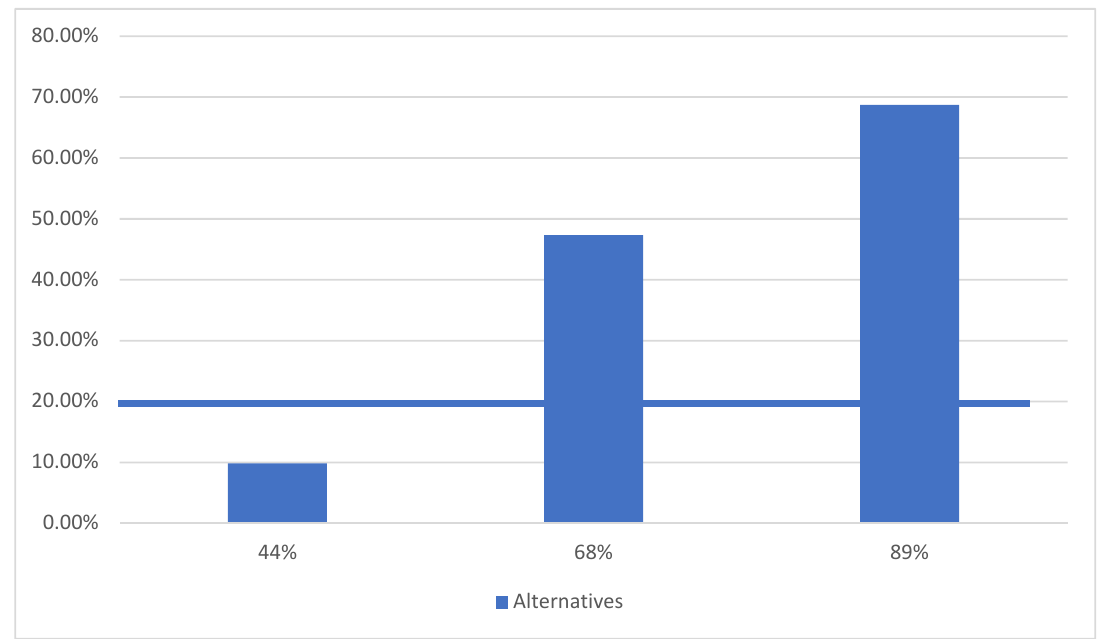
Figure 3. MARR to IRR Calculation Result.